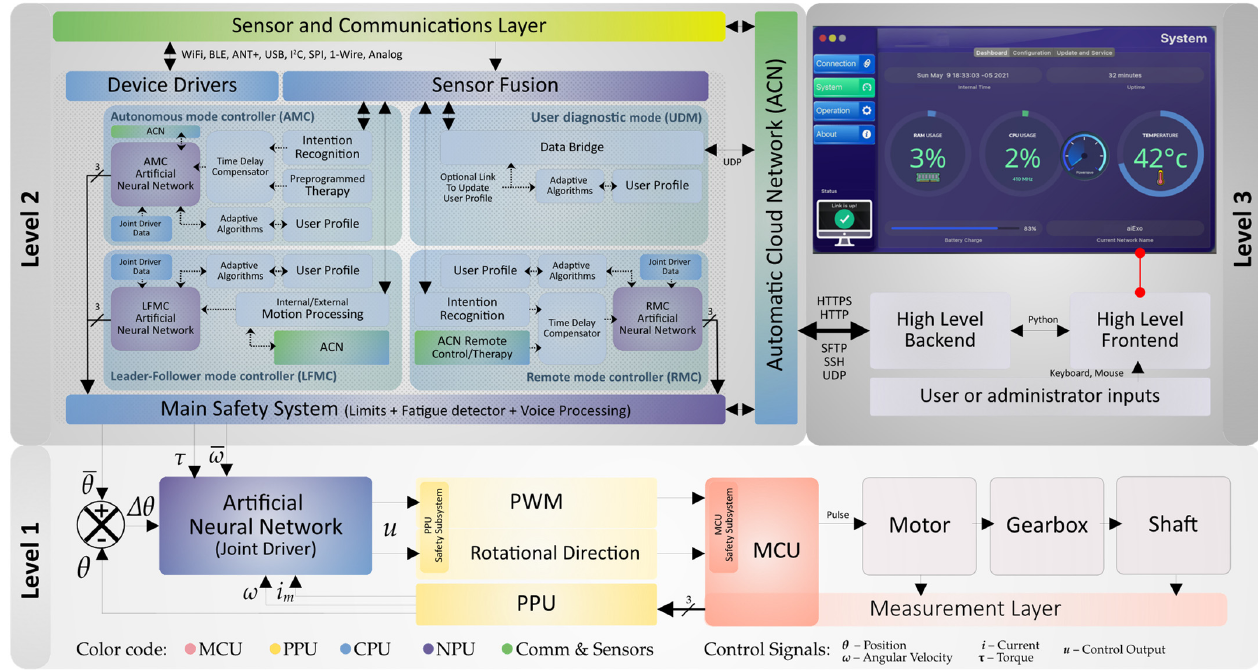
Figure 7. Block diagram of the exoskeleton prototype hierarchical control system.